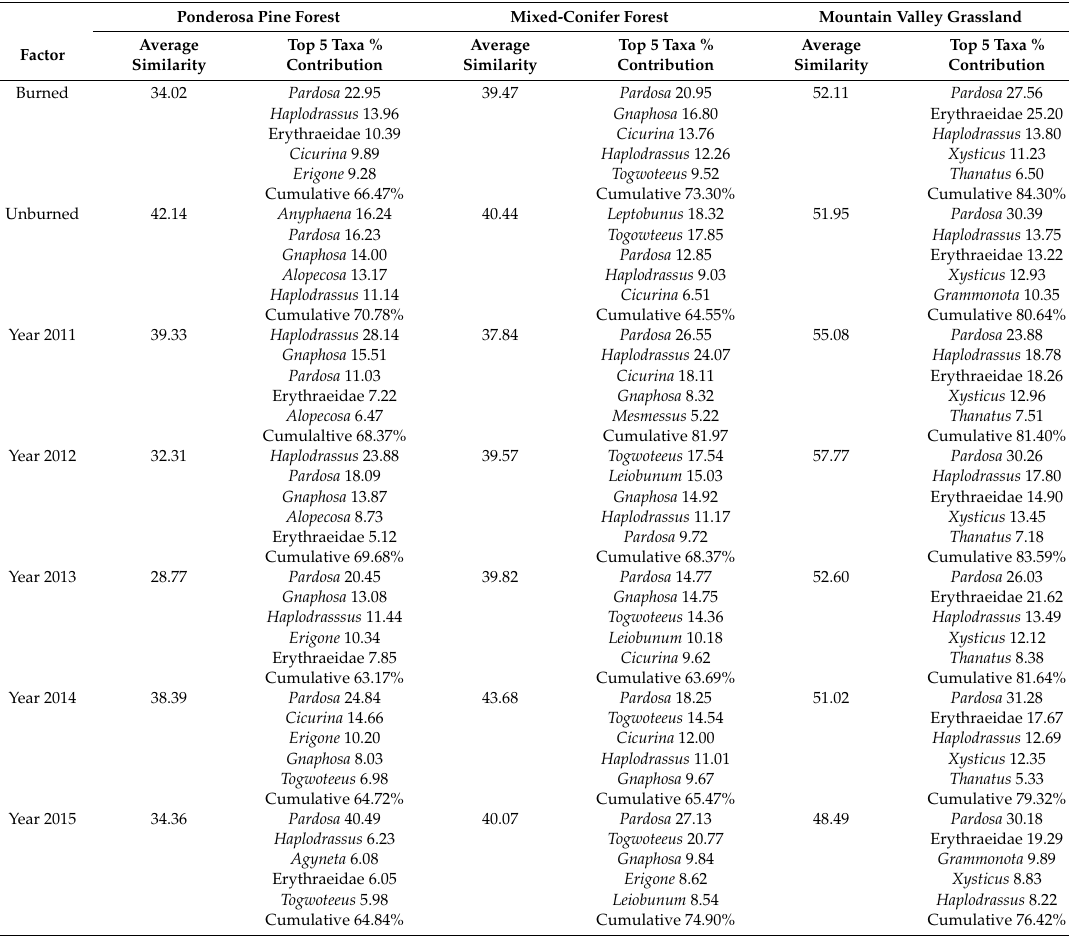
Table 3. Arachnid community SIMPER results by treatment and year for Ponderosa Pine Forest, Mixed-conifer Forest, and Mountain Valley Grassland at the Valles Caldera National Preserve.